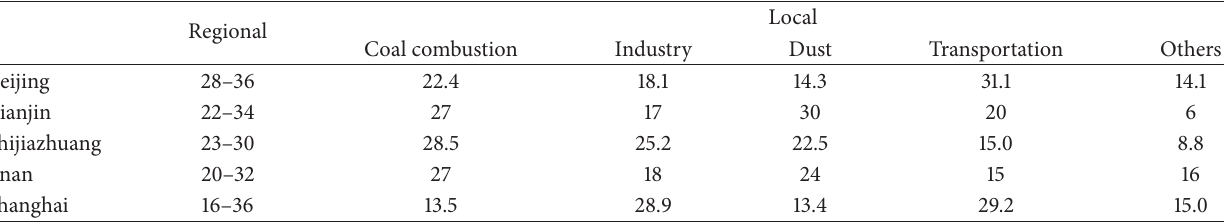
Table 1: The source contribution (%) of PM 2.5 in different cities of China. Local Regional Coal combustion Industry Dust Transportation